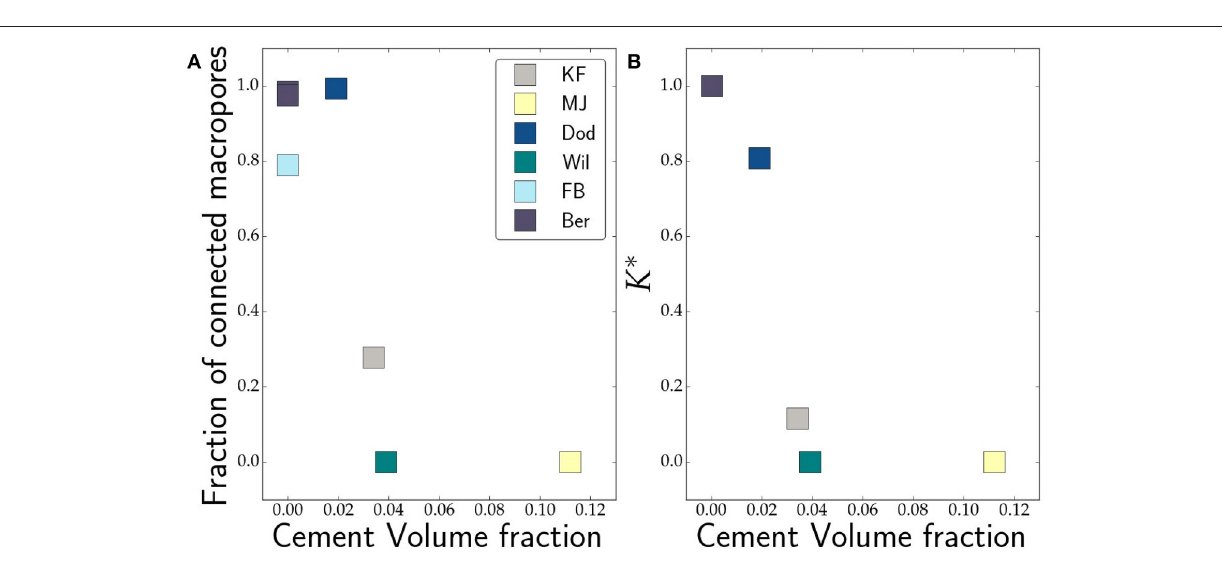
Frontiers in Earth Science |